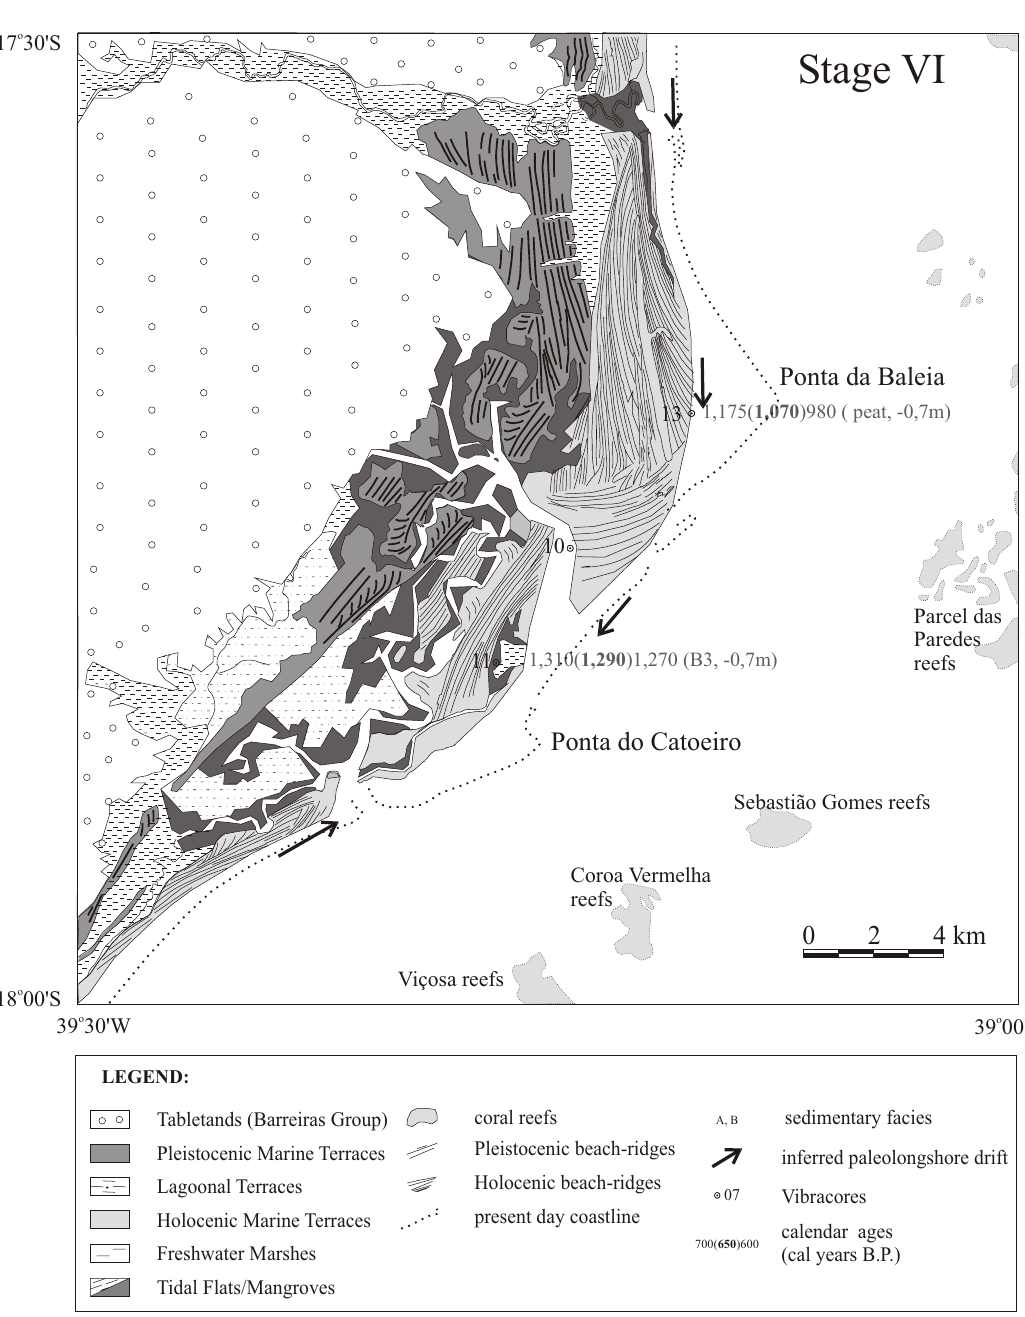
An Acad Bras Cienc (2003) 75